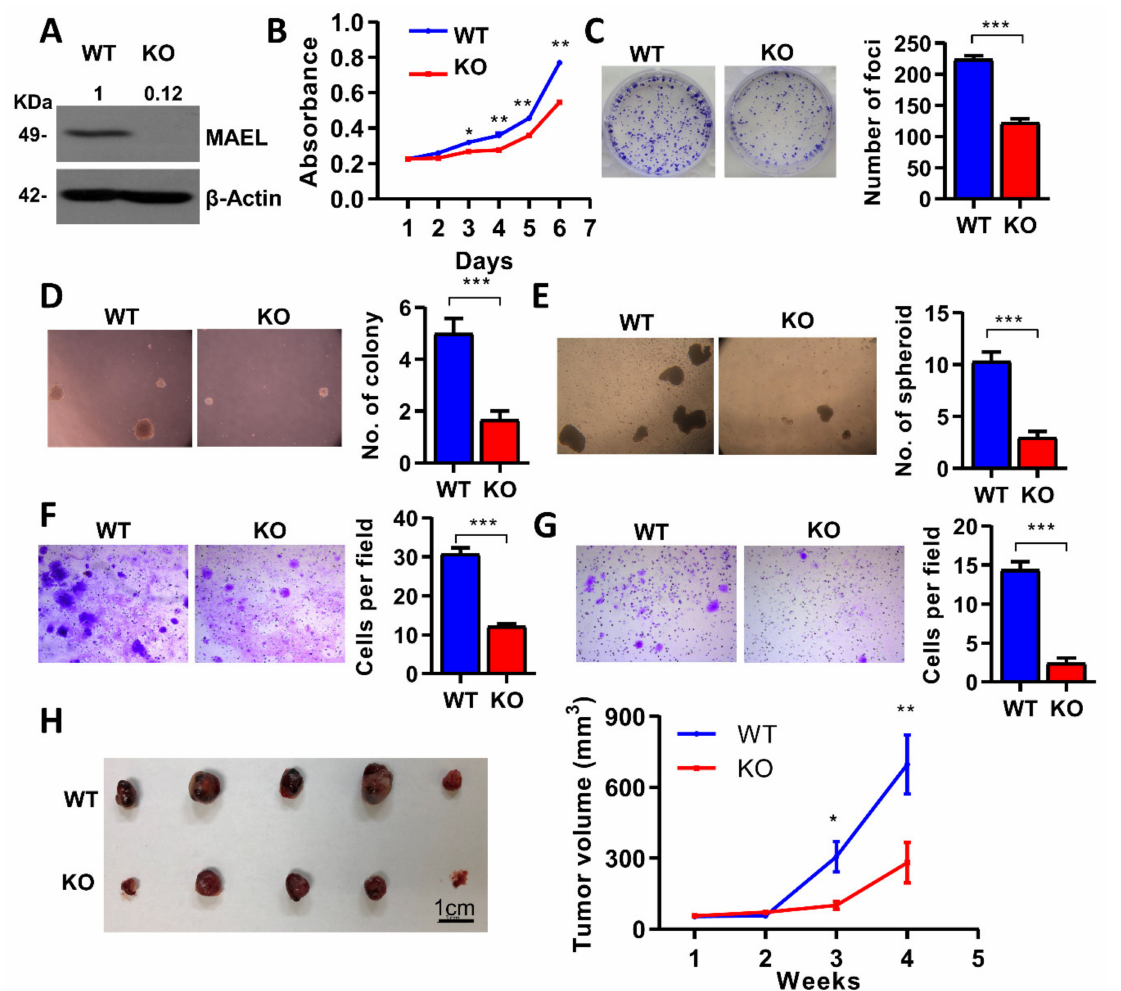
Figure 2. Deletion of MAEL-impaired aggressive phenotype in HCC. ( A ) Western blot validation of MAEL knockout in PLC8024 cells. β -Actin served as an internal control. Full Western Blot can be found in Figure S6. ( B ) Cell proliferation rate determined by XTT assay. Representative images and quantitation of ( C ) foci formation, ( D ) colony formation, and ( E ) spheroids in soft agar in MAEL wildtype and knockout PLC8024 cells. Representative images and quantitation of ( F ) migrated and ( G ) invaded cells in MAEL wildtype and knockout PLC8024 cells. ( H ) Representative images and tumor volumes of xenograft tumors derived from mice subcutaneously inoculated with wildtype or knockout cells ( n = 5 per group). WT, wildtype; KO: MAEL knockout. Scale bar stands for 1 cm. The values indicate the mean ± SD of three independent experiments. * p < 0.05; ** p < 0.01; *** p <